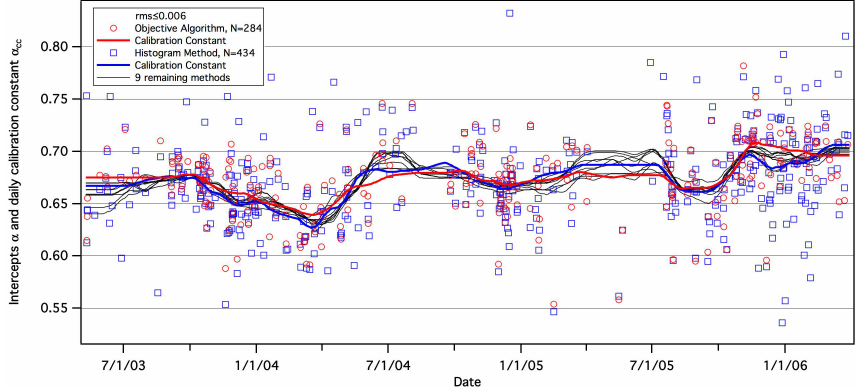
Figure 3. Calibration constant curves for all 11 methods (rms<0.006) and individual intercepts α for OA and H- β methods.